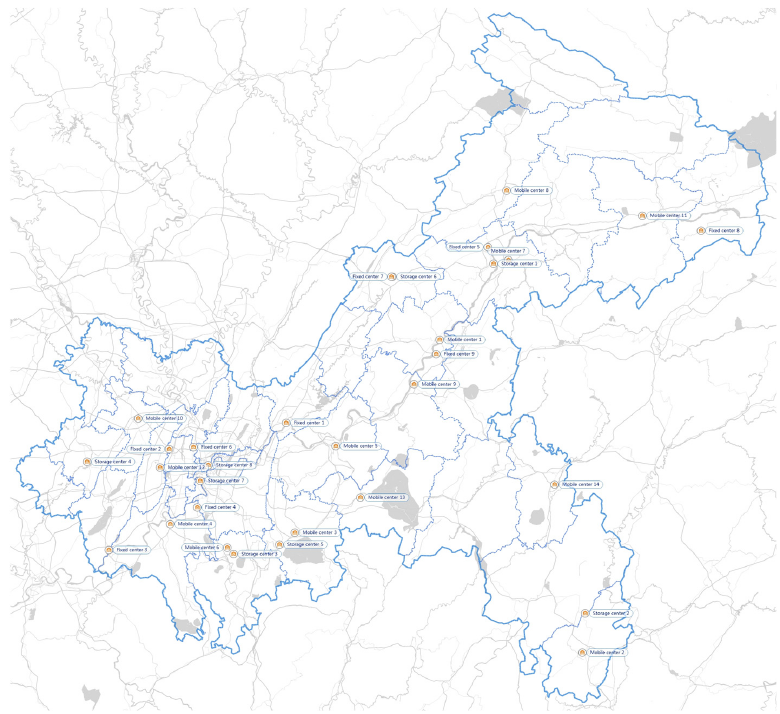
Figure 4. Storage centers in Chongqing.